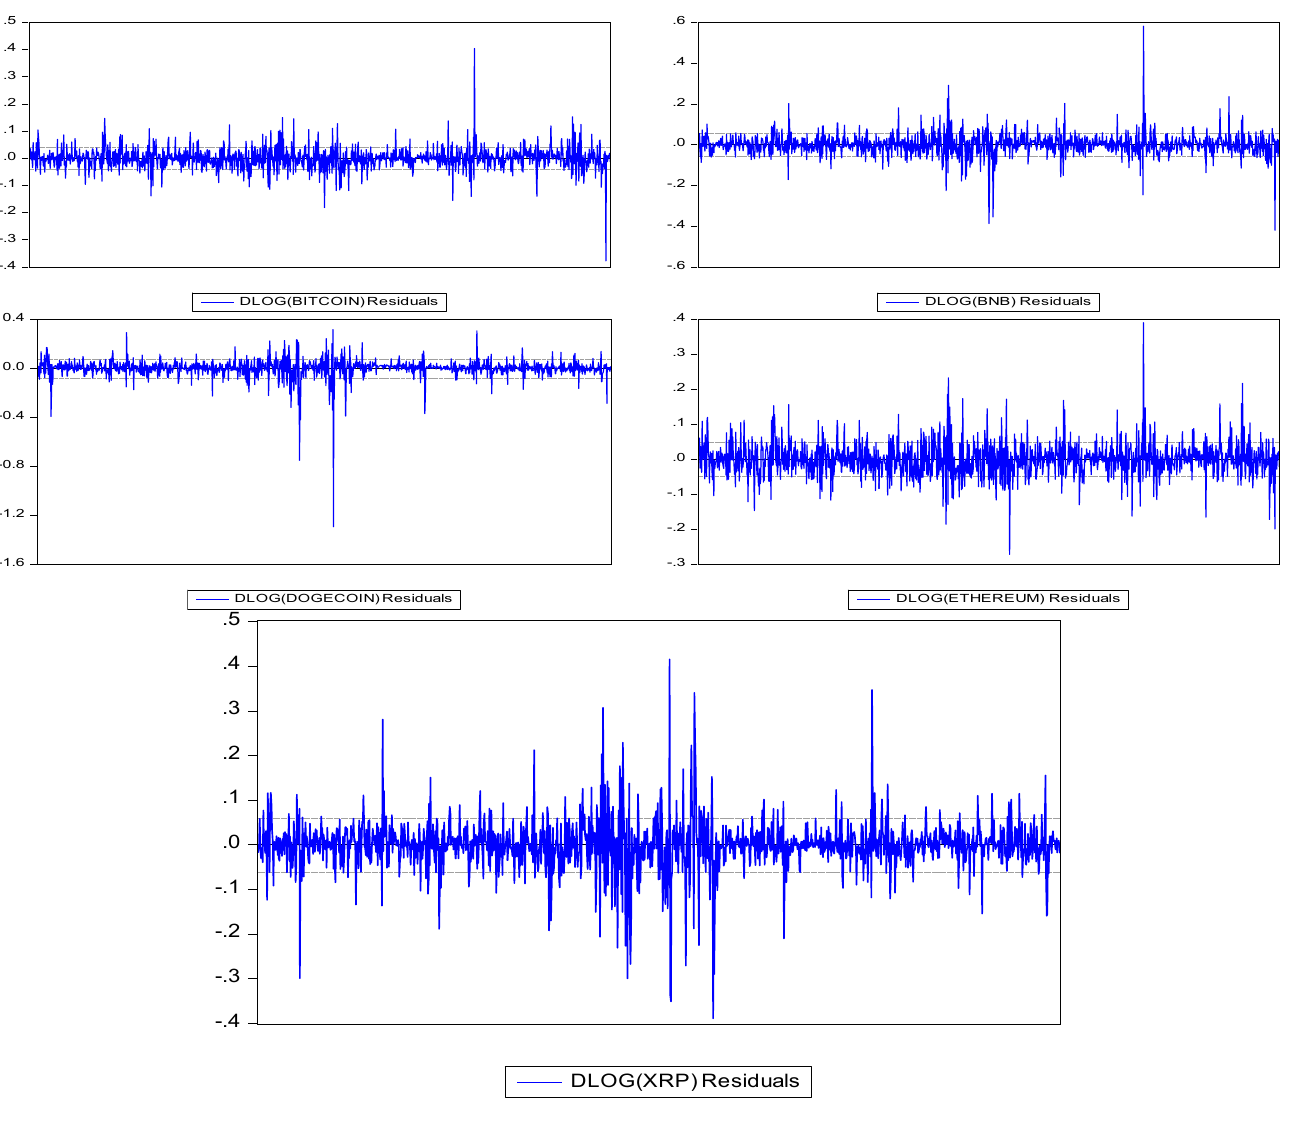
Figure 2. Volatility in Log Values of Residuals. Table 2. Correlation matrix of daily